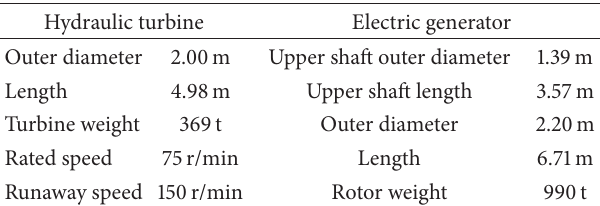
Table 1: Parameters of the generator